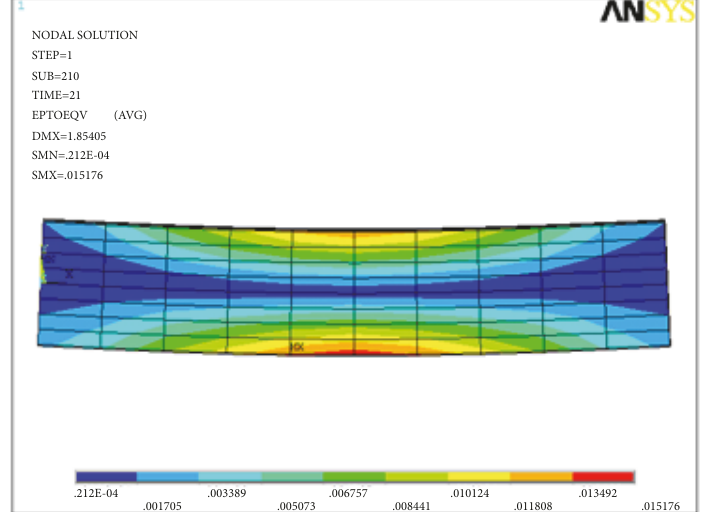
Figure 9: Elastic strain and plastic strain analyzed by ANSYS.